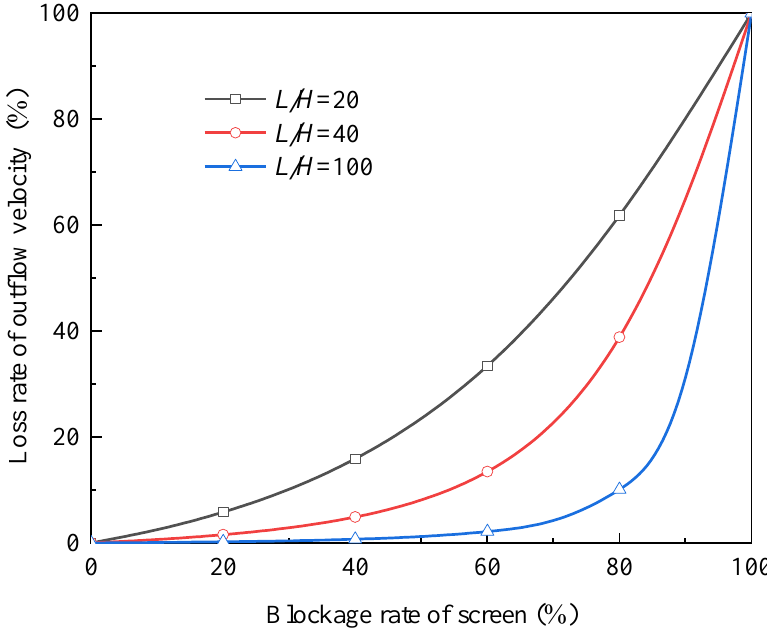
Figure 11. Characteristic curves influenced by L/H.